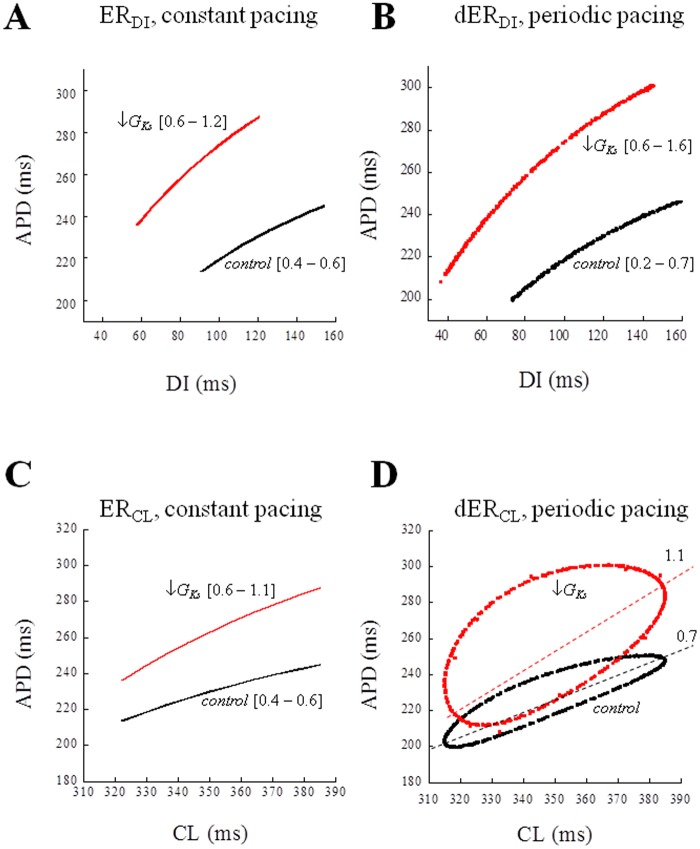
ER during constant and dER during periodic pacing.Classic ERDI (panel A) and ERCL (panel C) and dynamic dERDI (panel B) and dERCL (panel D) were measured before the perturbation (missing beat) in simulations, constant and periodic, like those in Fig 8C and 8D, in control conditions (black) and in diminished GKs conditions. In brackets, the range of slopes when CL was made to change ±35 ms around 350 ms. In the case of dERCL (panel D) the slope of hysteresis was approximated by measuring the slope of the major axis (dotted lines).